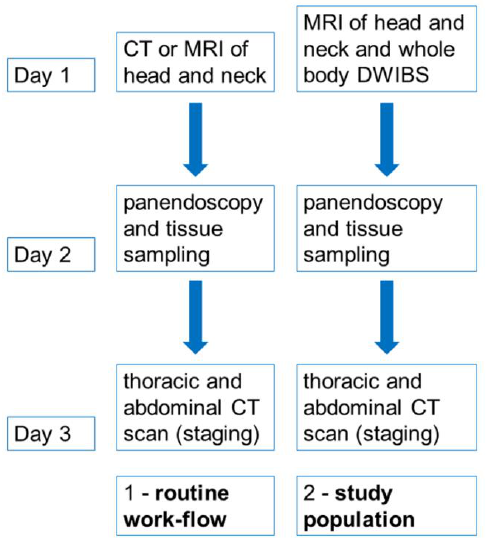
Figure 1. Routine diagnostic work-flow of patients with suspected head and neck cancer due to suspicious cervical lymphadenopathy compared to patients of our study